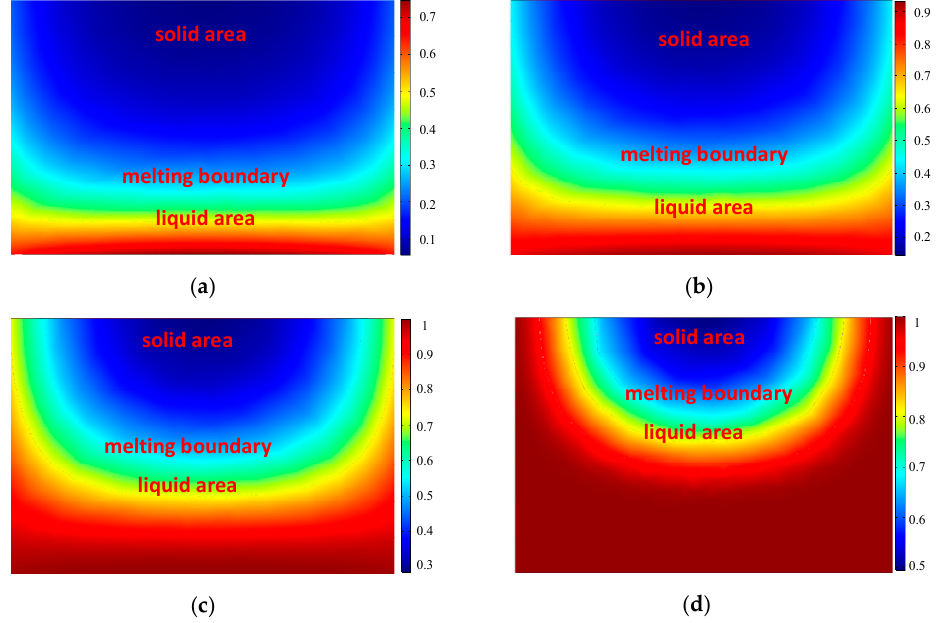
Figure 9. Plan view of melt front with time for the thickness of 8mm. ( a ) 350 s; ( b ) 400 s; ( c ) 450 s; ( d ) 500 s.